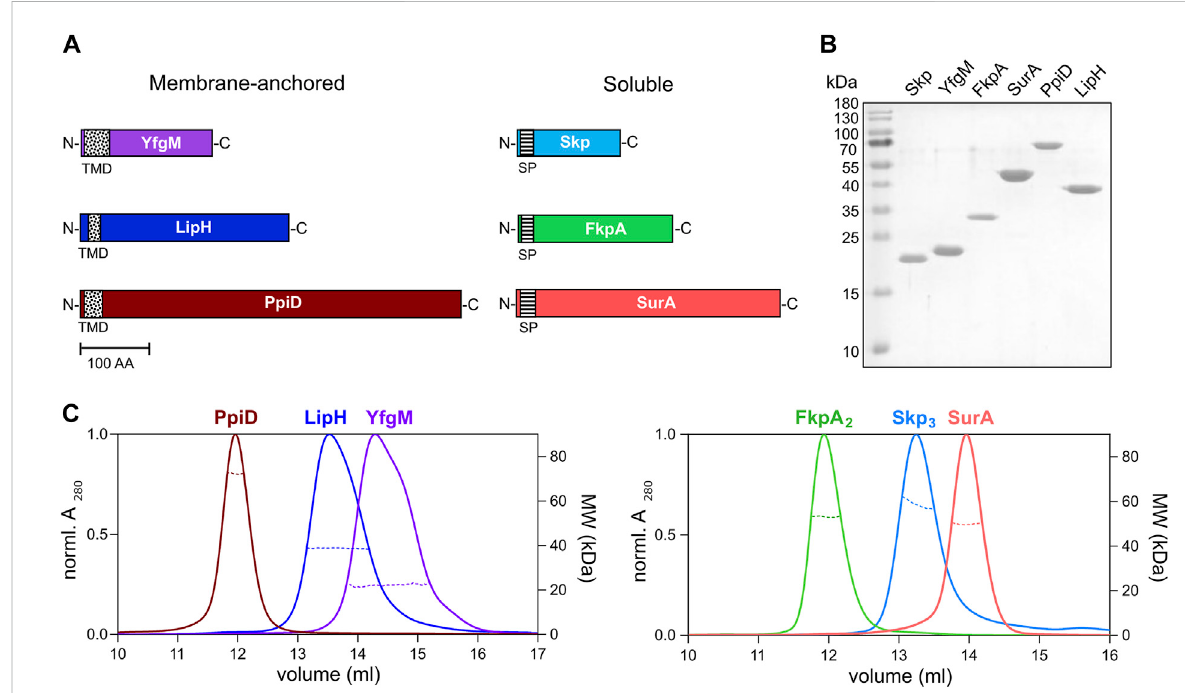
FIGURE 3 Periplasmic chaperones of P. aeruginosa PAO1. (A) Schematic overview of the periplasmic chaperones of P. aeruginosa PAO1. The predicted transmembrane domains (TMD, black-dotted) and the signal peptides (SP, black-ruled) were removed to express the soluble chaperones. Scale bar: 100 amino acid residues (AA). (B) SDS-PAGE of the isolated periplasmic chaperones of P. aeruginosa . (C) SEC-MALS analysis of the periplasmic chaperones to determine the oligomeric states in solution. Solid traces represent the absorbance at 280 nm, and dashed traces indicate the molecularweights( y -axisontheright)calculatedfromthelightscattering.TheanalysisrevealsdimersofFkpA(FkpA 2 )andtrimersofSkp(Skp 3 ),while SurA, YfgM, PpiD and LipH are monomeric in